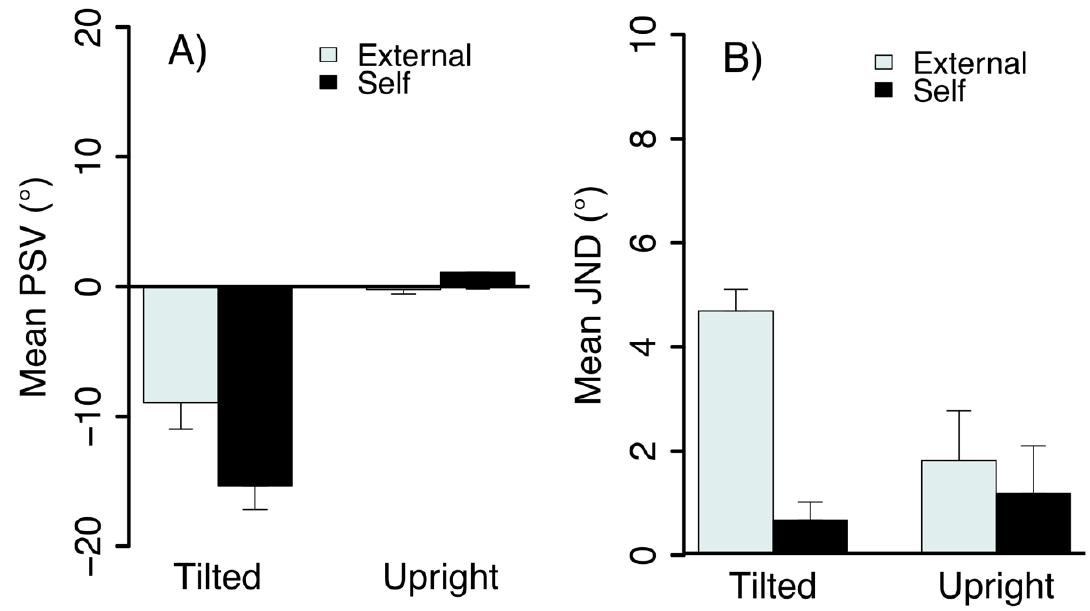
Figure 7. The mean ( A ) PSV and ( B ) JND as a function of body tilt and stimulus duration (±1 SEM).